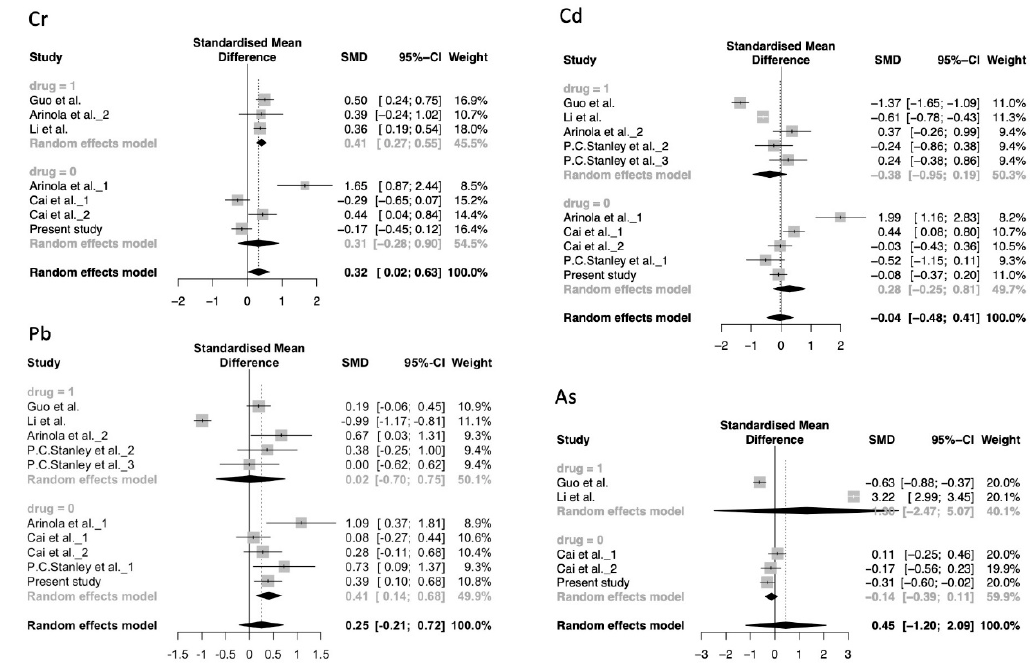
Figure 2. Forest plot of overall meta-analysis and subgroup analysis of the association between the concentration of each THM and schizophrenia. Overall pooled prevalence was calculated by random-effects module. drug = 1, patients with schizophrenia were treated with antipsychotic drugs. drug = 0, patients with schizophrenia were not treated with antipsychotic drugs. Horizontal bars show 95% CIs.